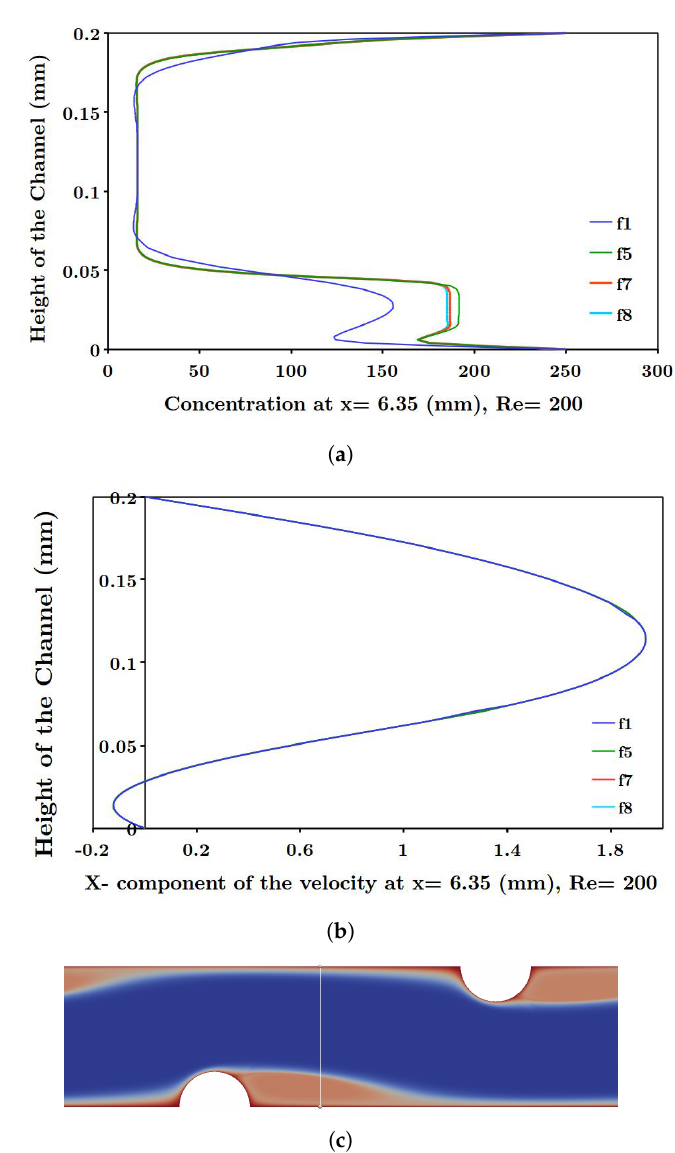
Figure 8. Concentration and velocity profiles along the height of the channel: ( a ) concentration profile with respect to the height of the channel at Re = 200, X = 6.35 mm for four different levels of mesh refinement; ( b ) X-component of velocity profile with respect to the height of the channel at Re =200 and X = 6.35 mm for four different levels of mesh refinement; and ( c ) position of investigated location (X = 6.35 mm) in cylindrical corrugated